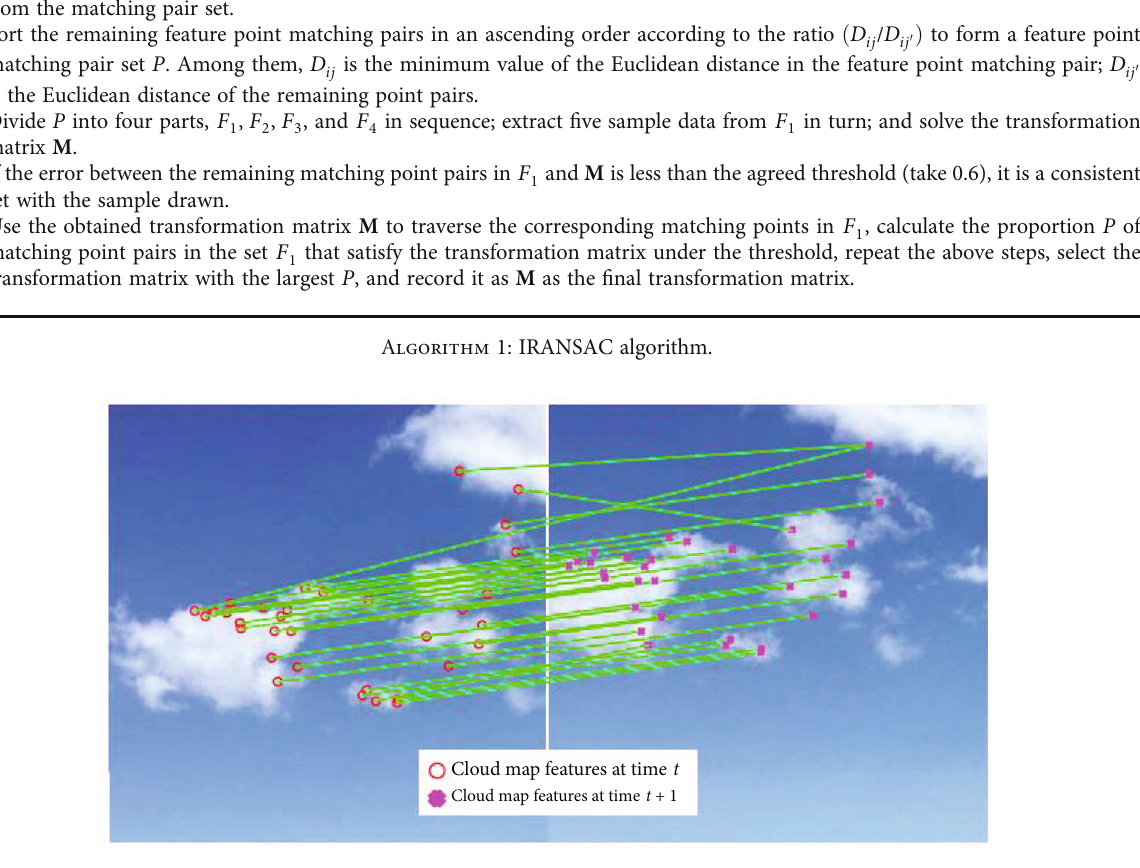
Figure 6: Matching process before